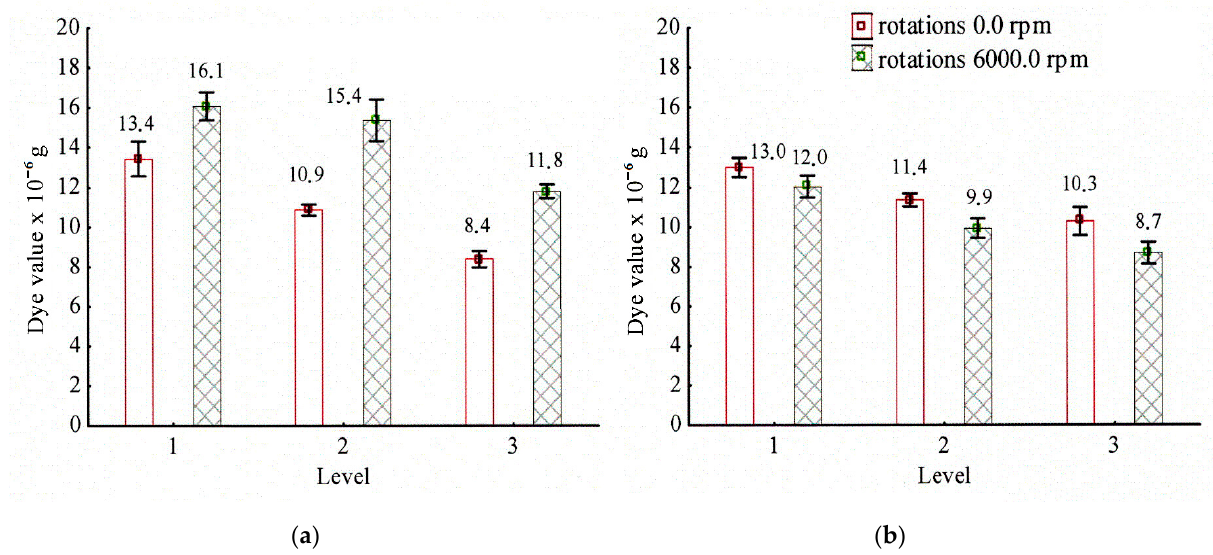
Figure 6. Distribution of the dye on particular levels of the samplers, placed on rods attached to poles, without trees, depending on the nozzle type and the rotational speed of the drone rotors: ( a ) Air-injector twin flat spray nozzle; ( b ) Air- injector flat spray nozzle.